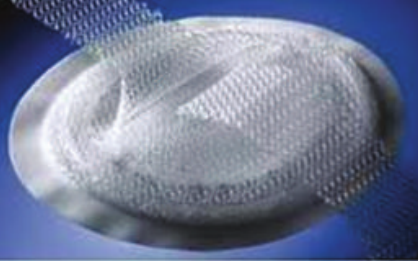
Figure 6: VENTRALEX Hernia Patch.